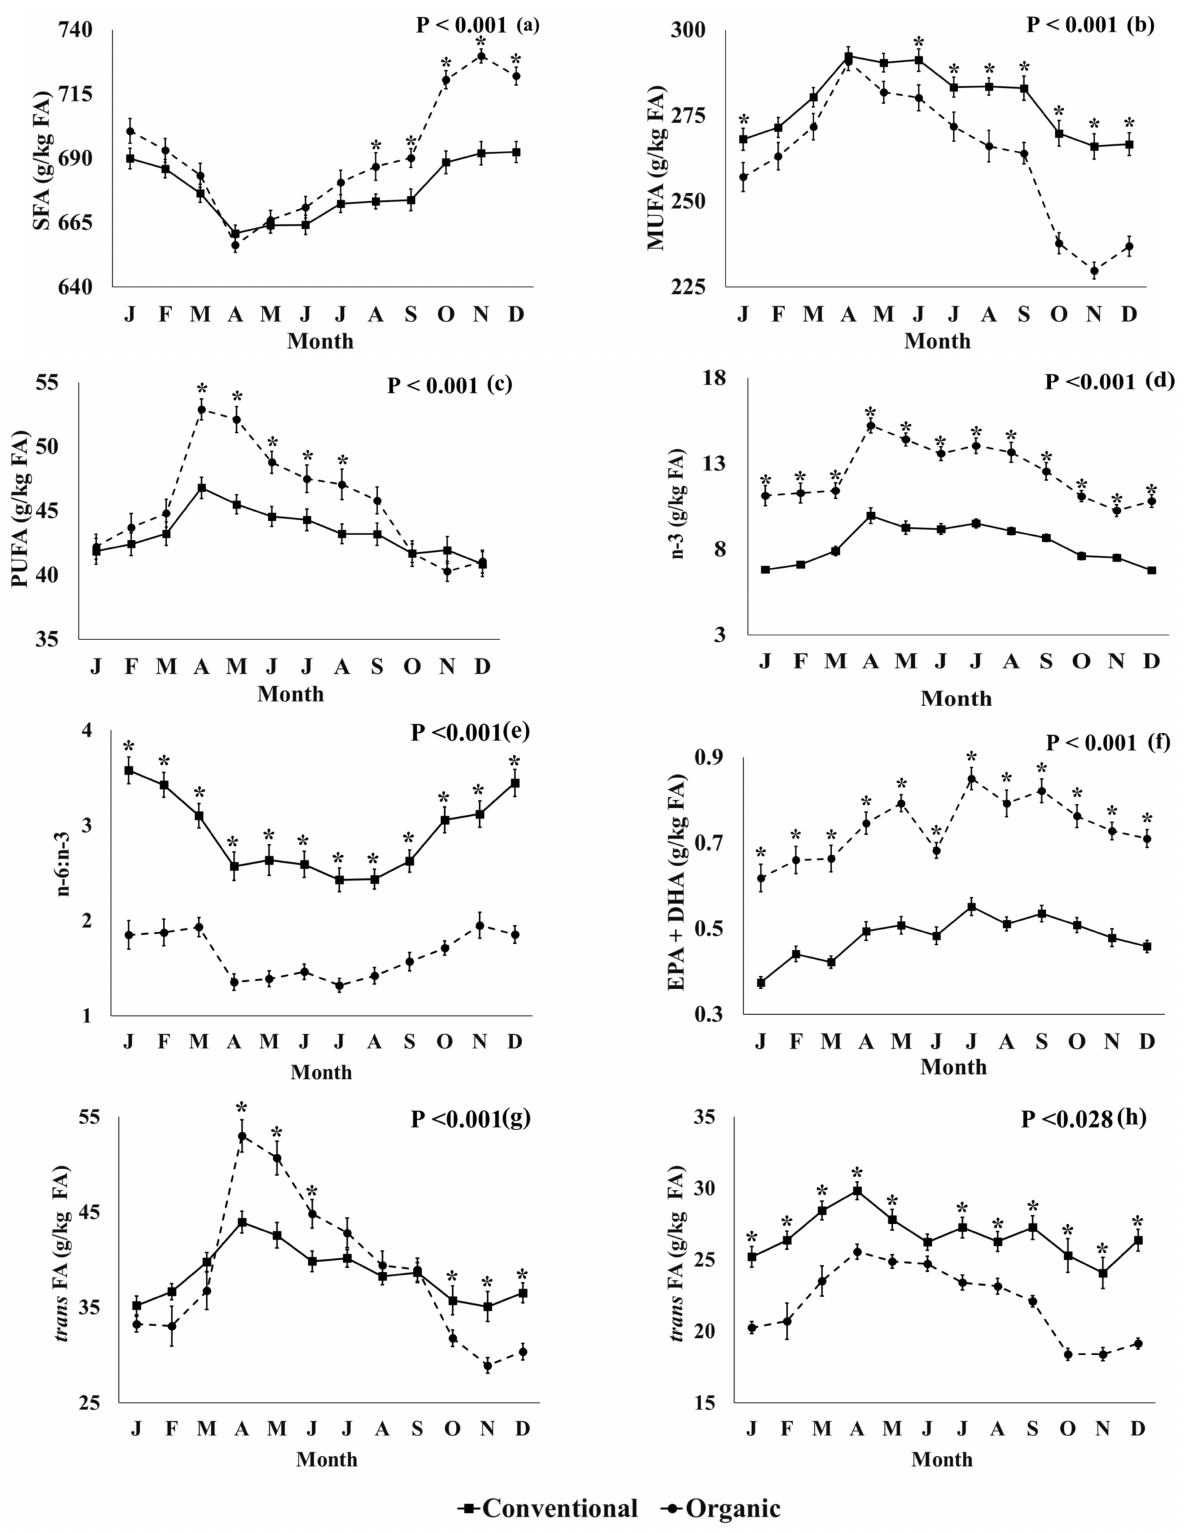
Figure 3. Fatty acid groups (( a ) SFA; ( b ) MUFA; ( c ) PUFA; ( d ) n-3; ( e ) n6:n3; ( f ) EPA + DHA; ( g ) trans FA; ( h ) trans FA (no VA)), where a significant ( p < 0.05) interaction between the production system (conventional, solid line; organic, dotted line) and the month was observed. *: significant difference between conventional and organic farms within the month ( p < 0.05). Means were calculated from the measured values. The error bars represent the standard error of the